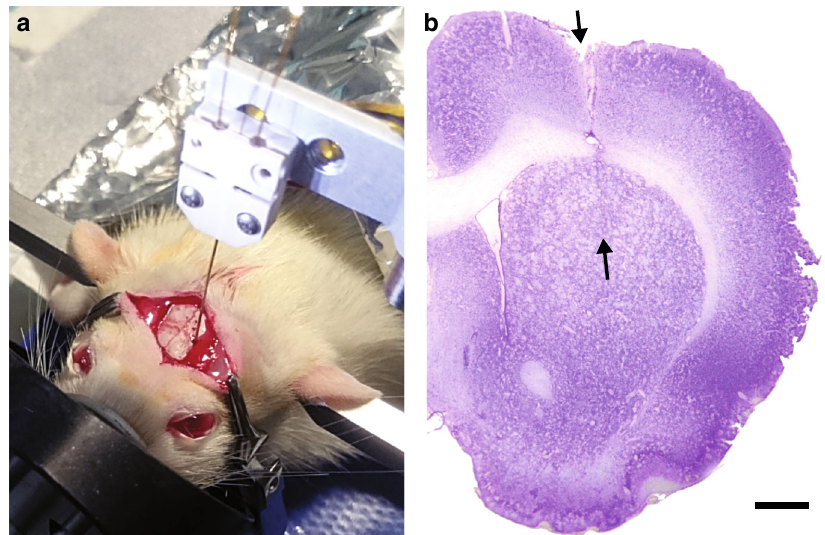
Fig. 2 Surgical set-up during left brain hemisphere implantation on a rat. a The neural probe is maintained in the interface unit which is fi xed on the stereotactic arm. b Stained left brain hemisphere after implantation of the neural probe. The black arrows represent the entry point and the end of the probe tip when inserted in the cerebral tissues (scale bar = 1